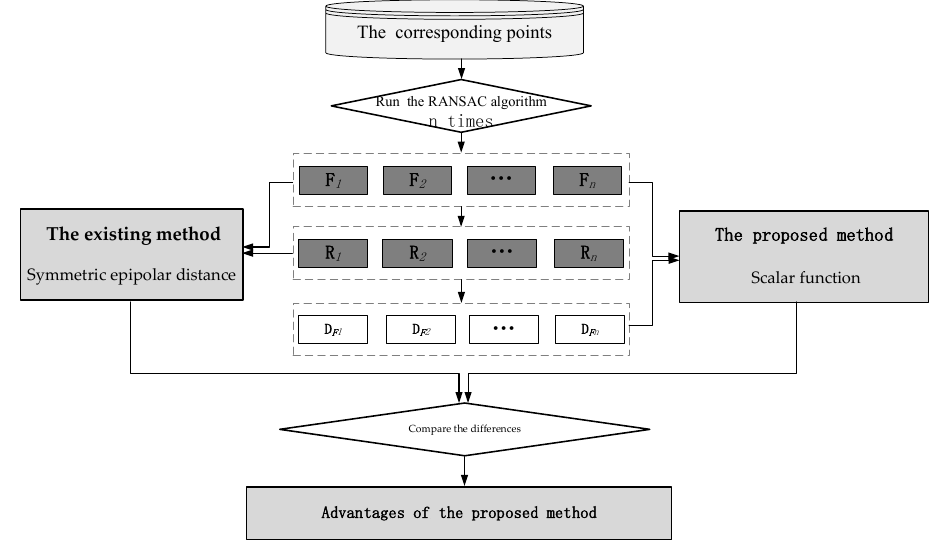
Figure 7. Comparative flowchart with the existing method.